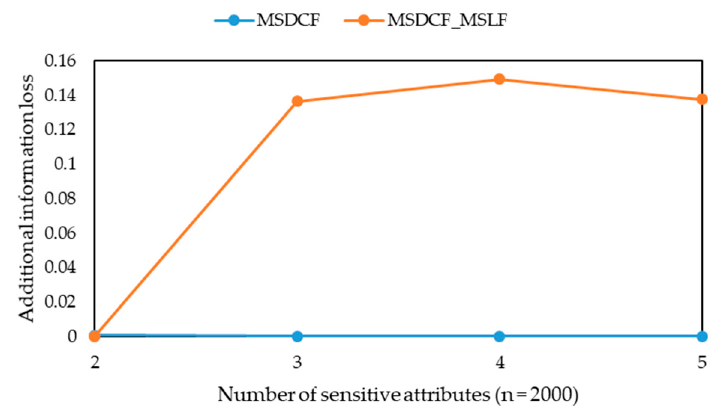
Figure 11. The additional information loss of MSDCF and MSDCF-MSLF with different sensitive attribute numbers ( n = 2000).